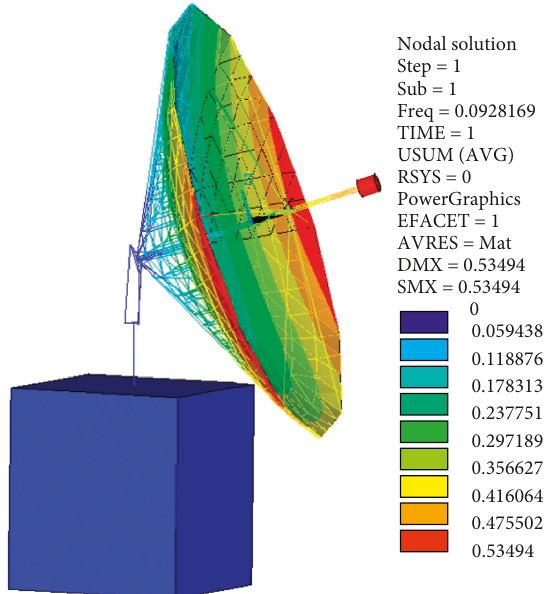
Figure 21: Fundamental frequency of the SSPCI at a limit